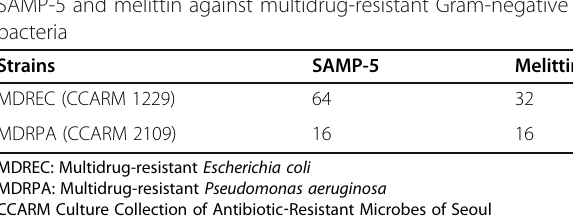
Resistance assay Table 1 Minimal inhibitory concentrations (MICs; μ g/ml) of